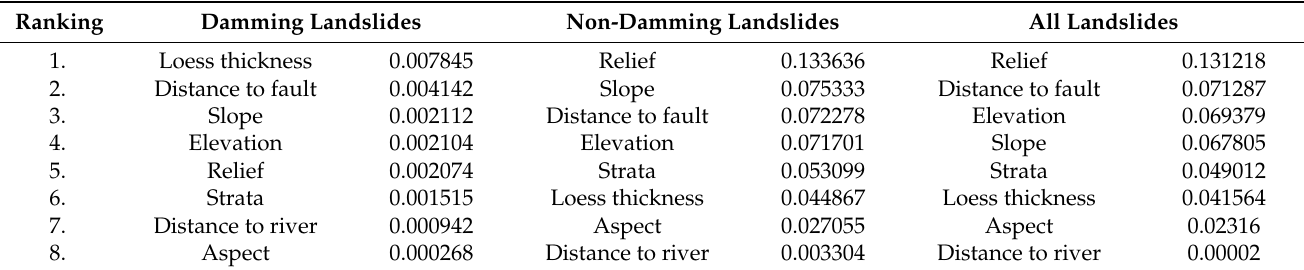
Table 2. Ranking of IG values.